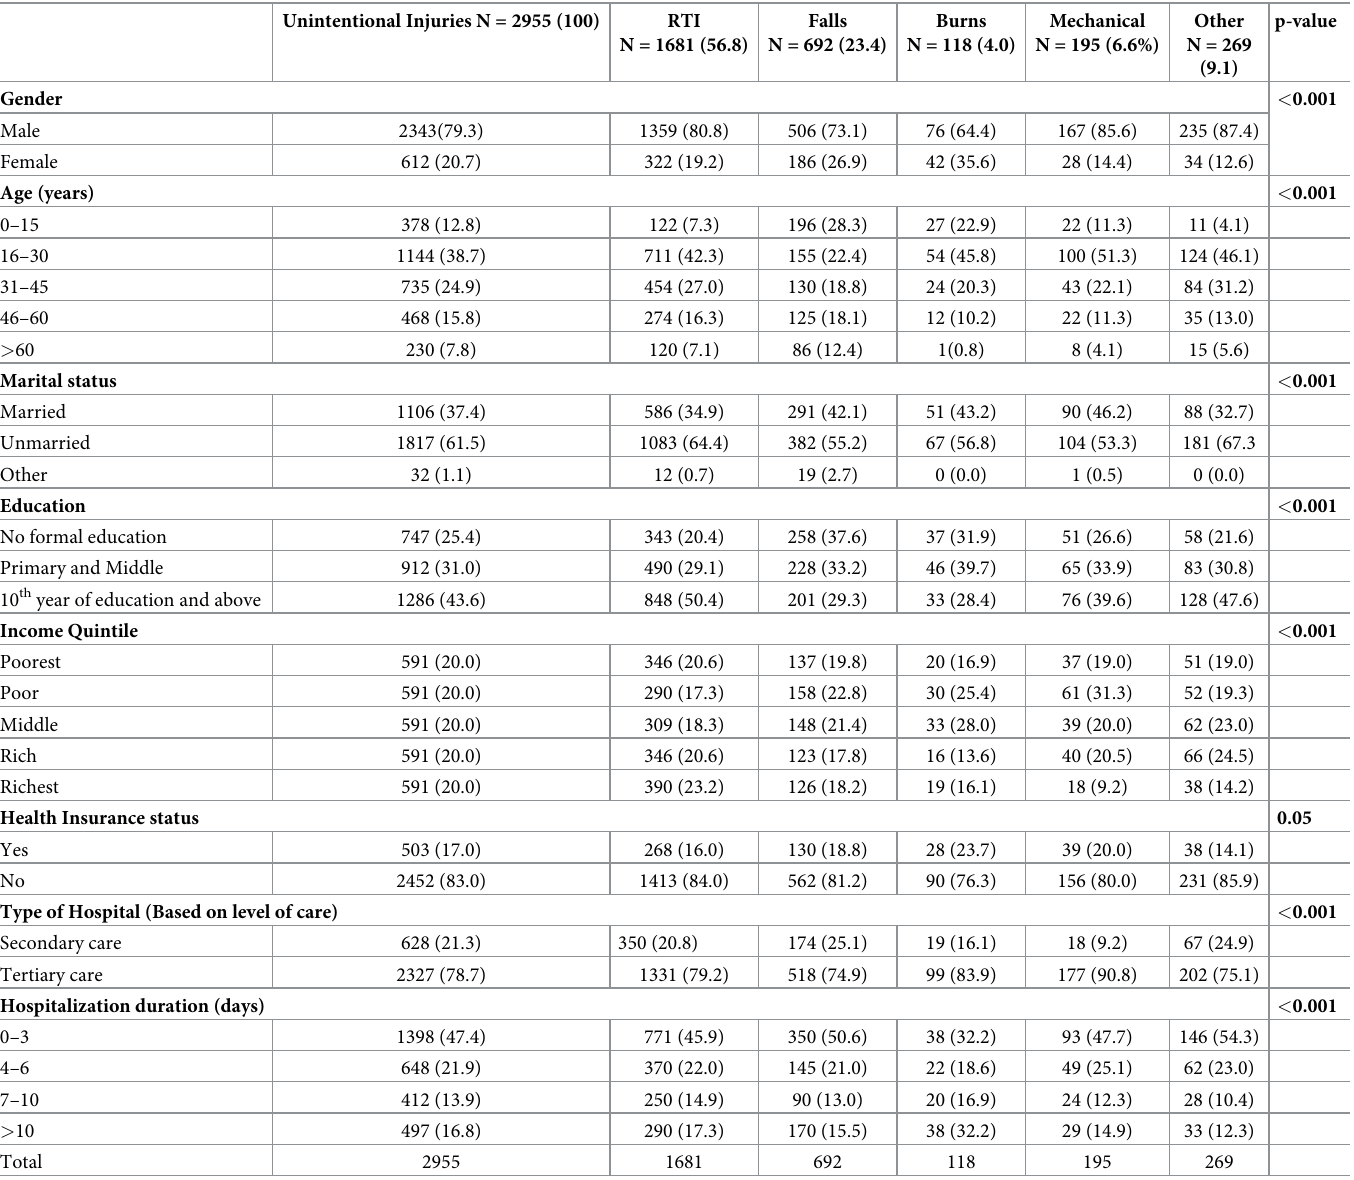
Table 1. Socio-demographic profile of injury